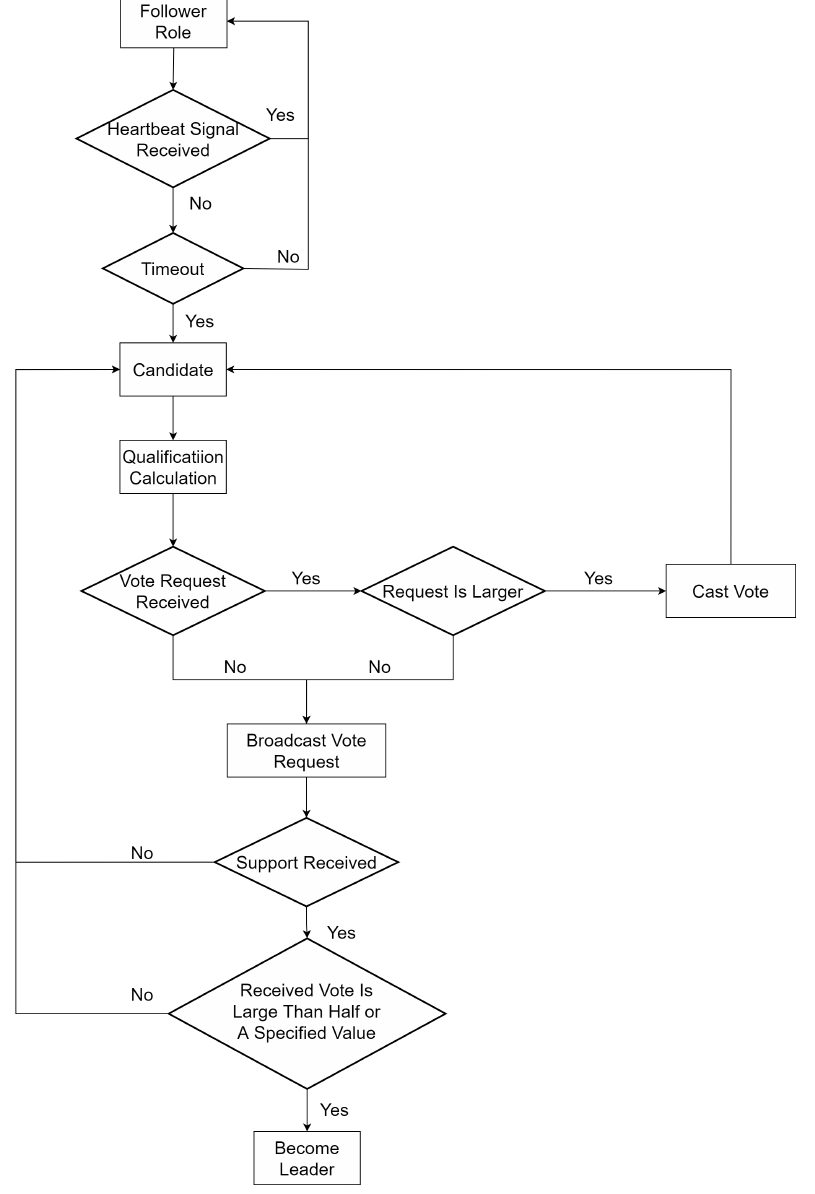
Figure 5. The program flow